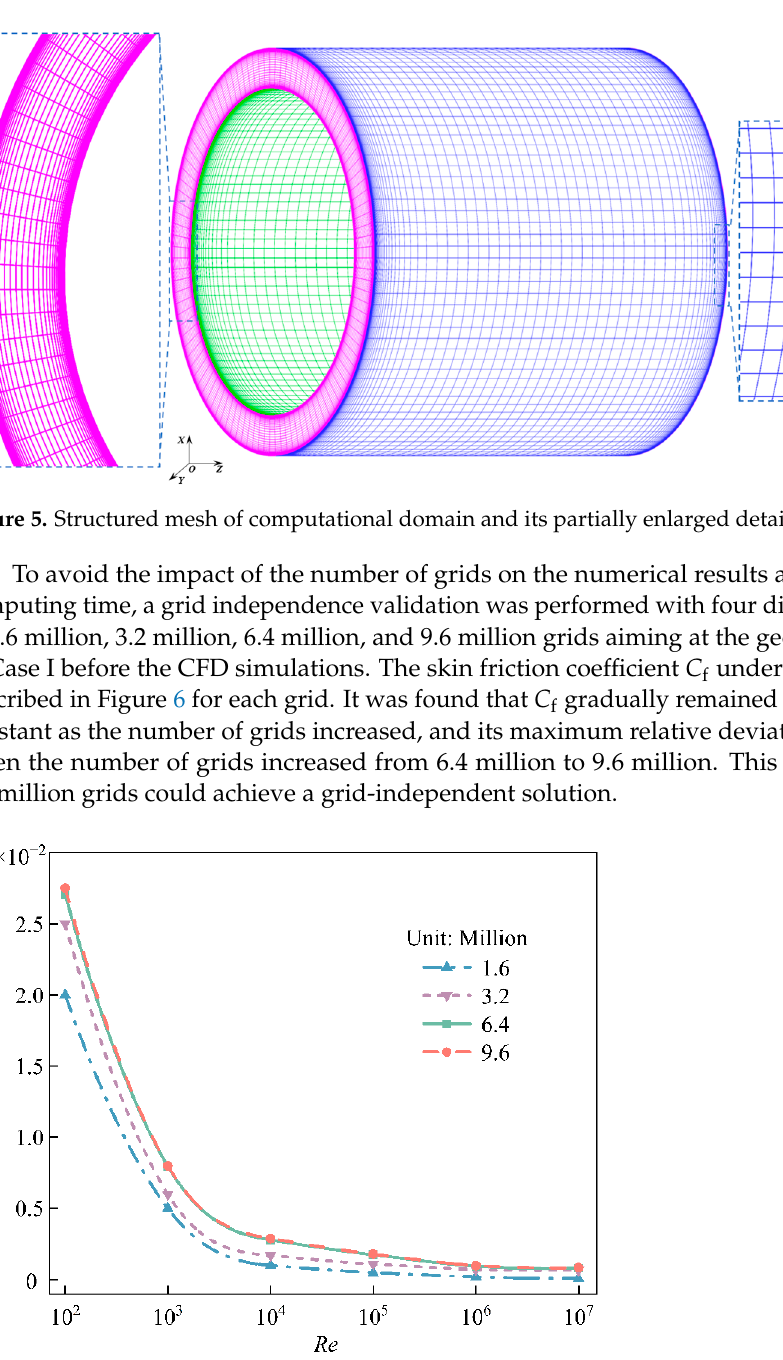
Figure 6. Skin friction coefficient C f under different Re for four different meshes of 1.6 million, 3.2 million, 6.4 million, and 9.6 million